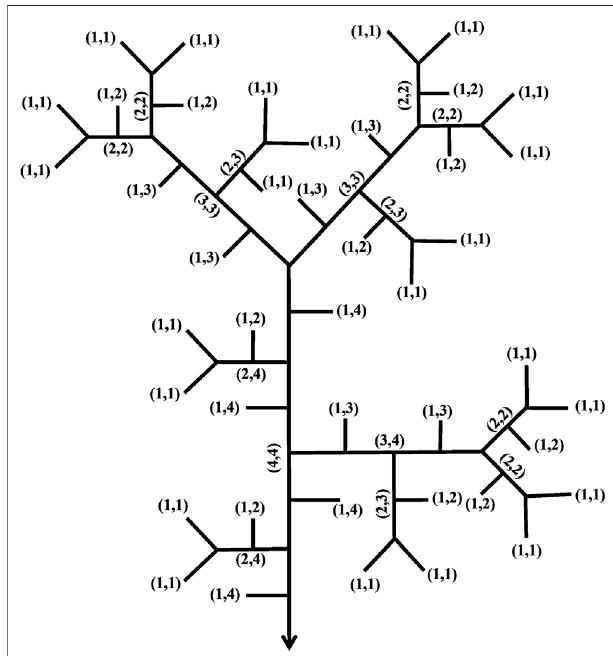
FIGURE 2 | Schematic diagram for the Tokunaga ordering method for a binary tree (from Zhang et al.,